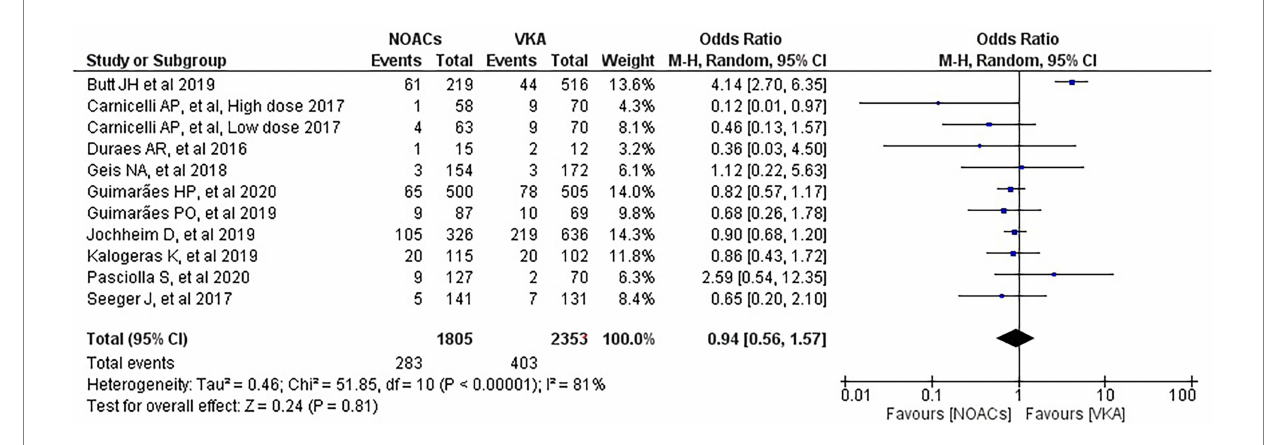
FIGURE 2 Forest plot of bleeding for DOACs compared with VKA. M-H, Mantel–Haenszel test; CI, confidence interval.